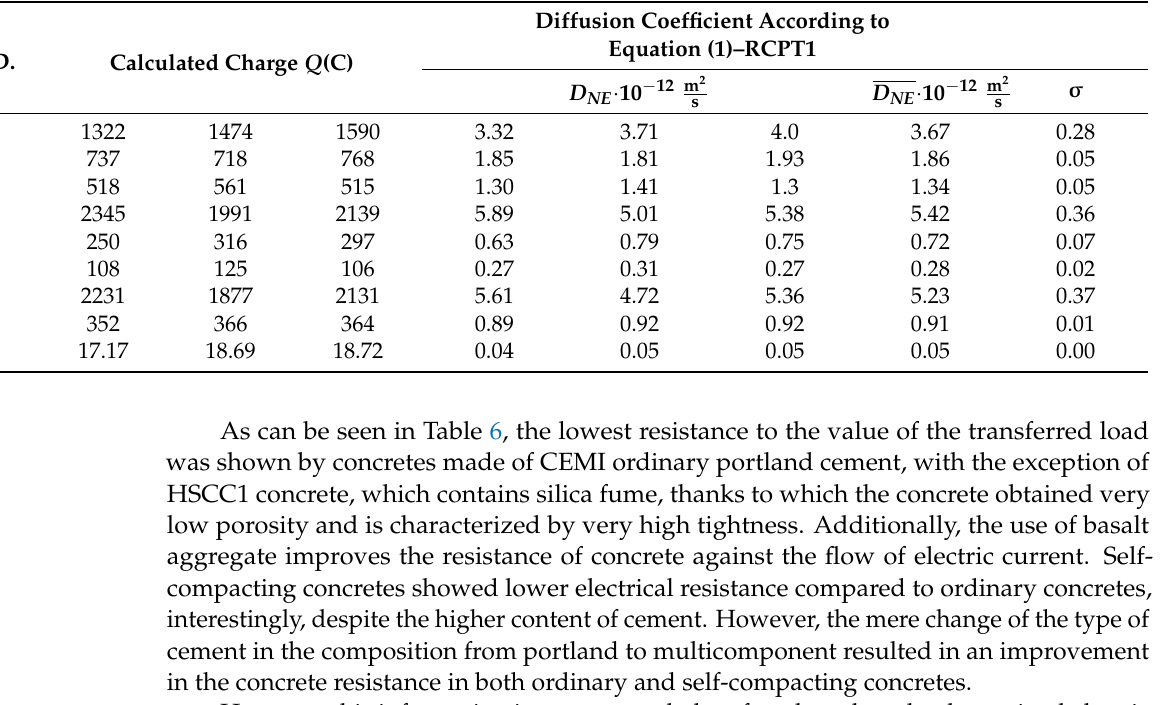
Table 6. Results calculated charge Q for chloride migration tests RCPT1 and diffusion coefficient computed according to Equation (1) for selected